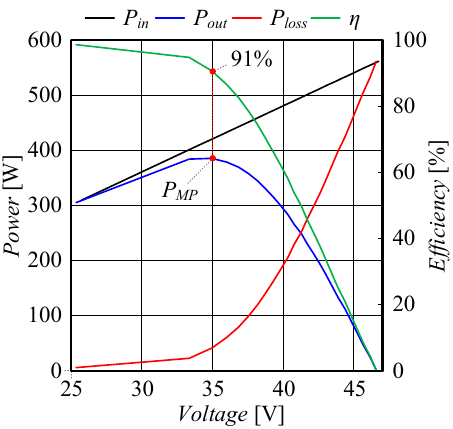
Figure 22. The relationship of the input power, output power, and power loss with efficiency in the PVE prototype. Table 3. Comparison of the PVE Efficiency According to the Value of R s,add .